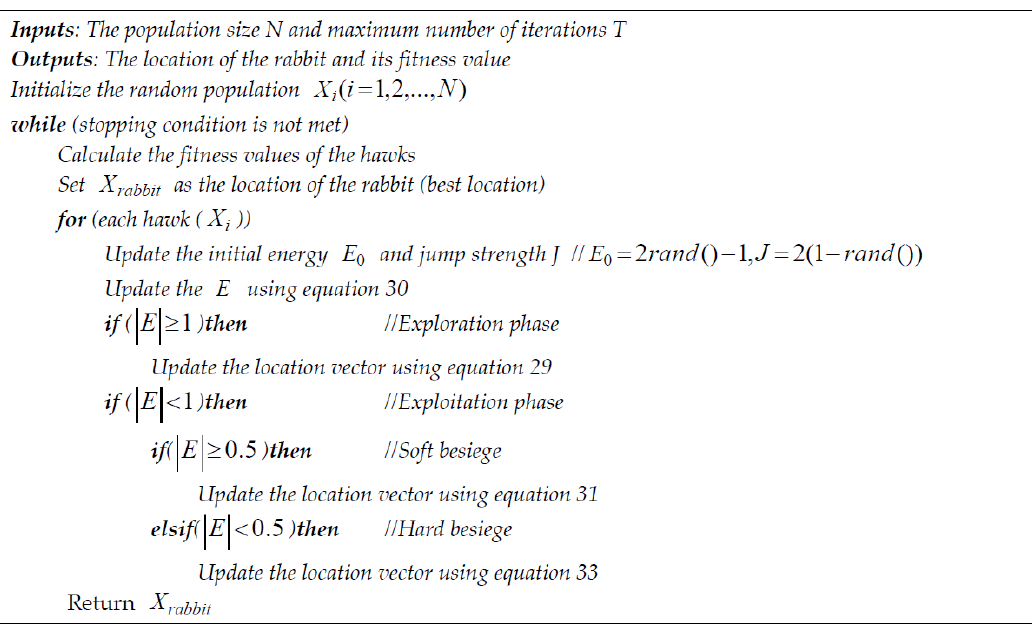
Figure 3. Pseudo code of the Harris Hawks Optimization algorithm.